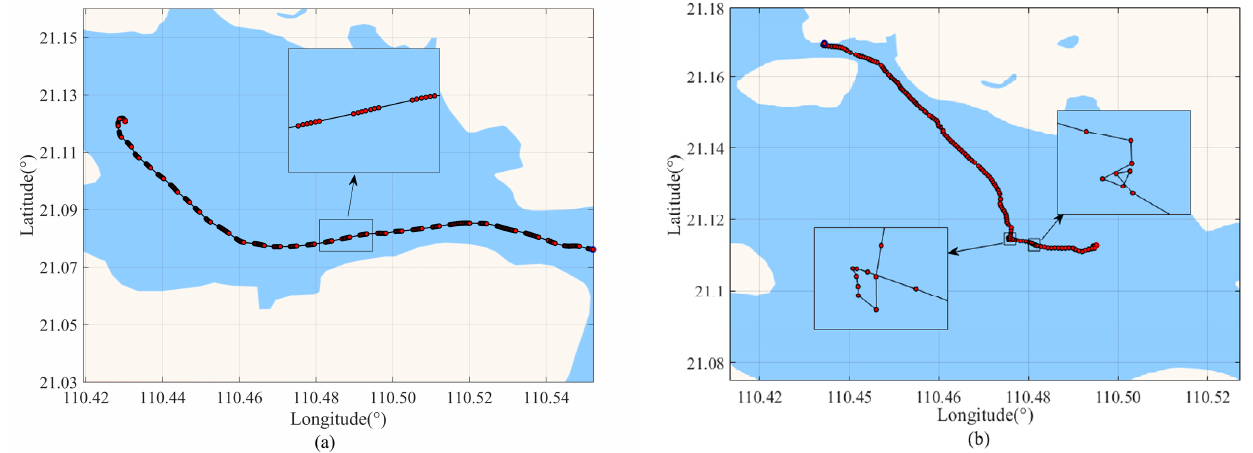
Figure 22. Example of abnormal trajectories of outgoing and incoming ships. ( a ) Abnormal trajectory in Figure 10a; ( b ) abnormal trajectory in Figure